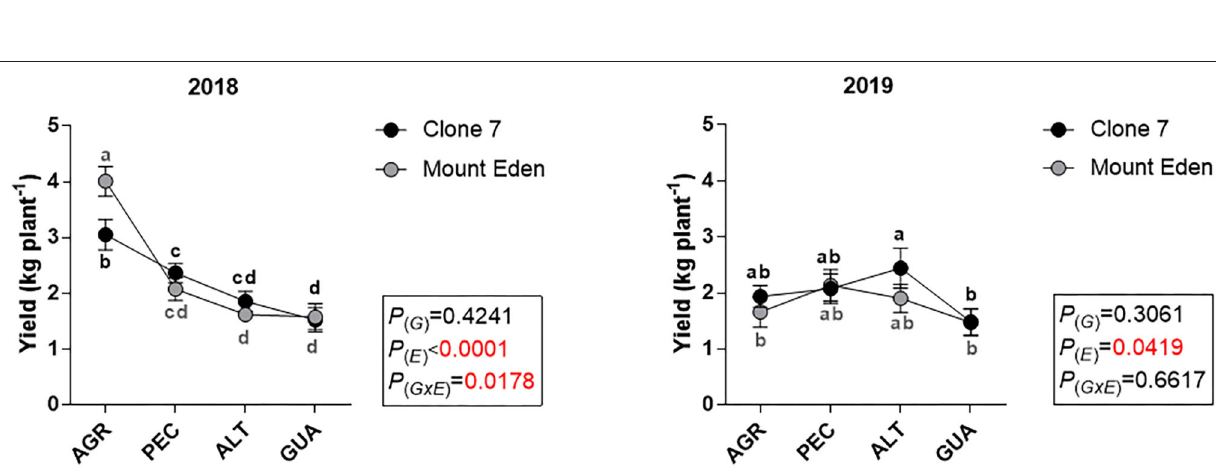
FIGURE 3 | Fruit yield indicators, measured during 2018 and 2019 growing season for two Cabernet Sauvignon clones (Clone 7 and Mount Eden) in four vineyards (AGR, PEC, ALT and GUA). Fruit yield (A) , number of clusters per plant (B) , Berry fresh weight (C) and berry skin dry weight (D) . Values are means ( n = 9) and different letters indicate statistically significant differences (LSD Fisher; P ≤ 0.05). P (E) , P (G) and P (GxE) : effects of environment, genotype and their interaction, respectively. For the 2019 growing season, the AGR vineyard was affected by a hail storm that affected the plants canopy near the harvest date. Supplementary data in Supplementary Tables 2 – 4